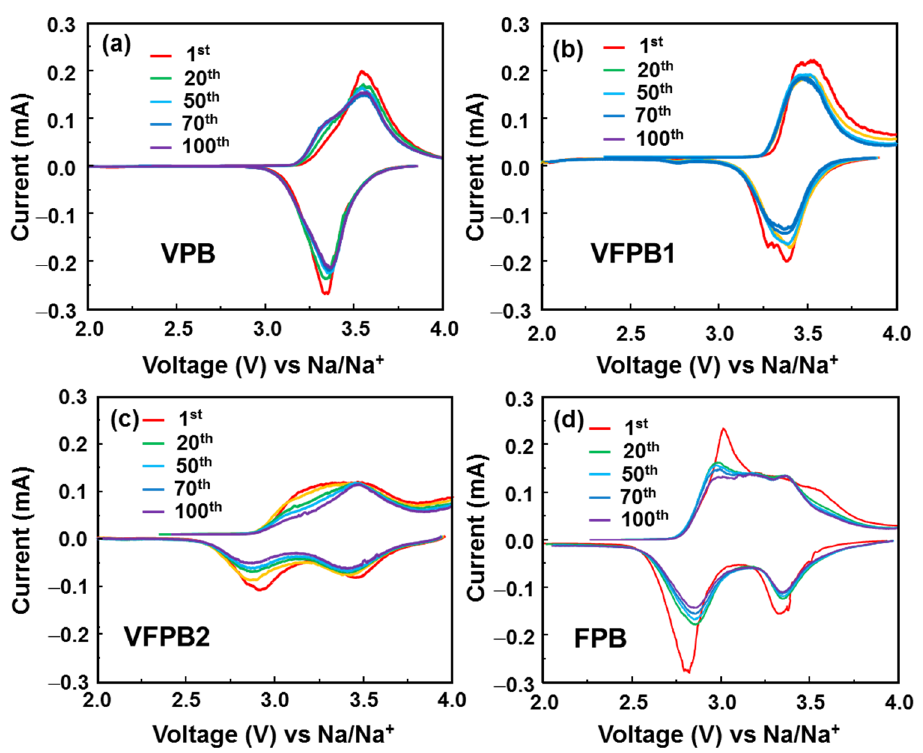
Figure 6. DCP plots during charge/discharge process at various cycles for ( a ) VPB, ( b ) VFPB1, ( c ) VFPB2, and ( d ) FPB cathodes.